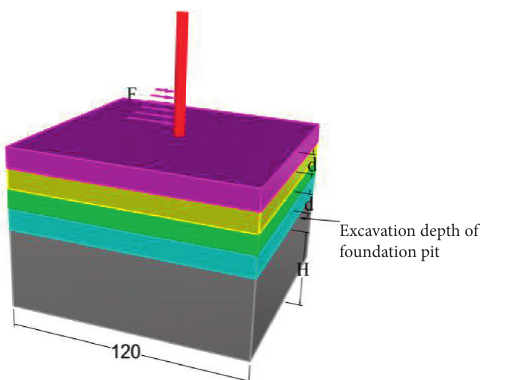
Figure 7: Model of a retaining pile based on numerical calculations.